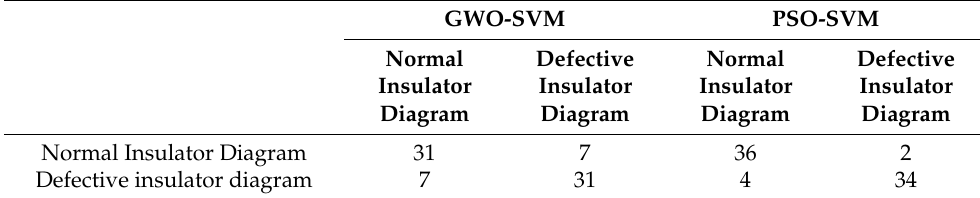
Table 7. Insulator image classification